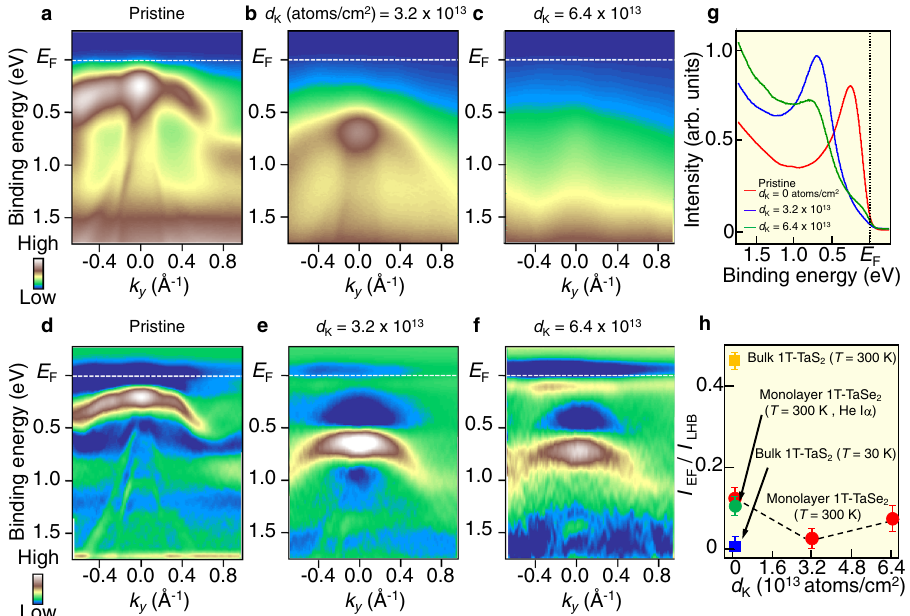
Fig. 3 CDW – Mott insulator phase in monolayer 1T-TaSe 2 robust against electron doping. a – c K-deposition dependence of ARPES intensity along the Γ K cut for monolayer 1T-TaSe 2 [potassium coverage d K = 0 (pristine), 3.2 × 10 13 , and 6.4 × 10 13 atoms/cm 2 , respectively], measured at T = 300 K with h ν = 51 eV. d – f Same as a – c , but obtained by taking the second derivative of EDCs. g EDCs at the Γ point for each d to that at LHB, I EF / I LHB , as a function of d K , estimated from the EDCs in g . The values for bulk TaS 2 measured at T = 30 and 300 K are also plotted. Error bars re fl ect the uncertainties originating from the energy resolution and statistics of data. Asymmetry in the intensity pro fi le in a and b is associated with the inequivalent photoelectron matrix-element effect between positive and negative k y ’ s (Supplementary note 8 and Fig. Nd magnet (magnetic fi eld ~ 500 mT) on top of a fi lm to detect